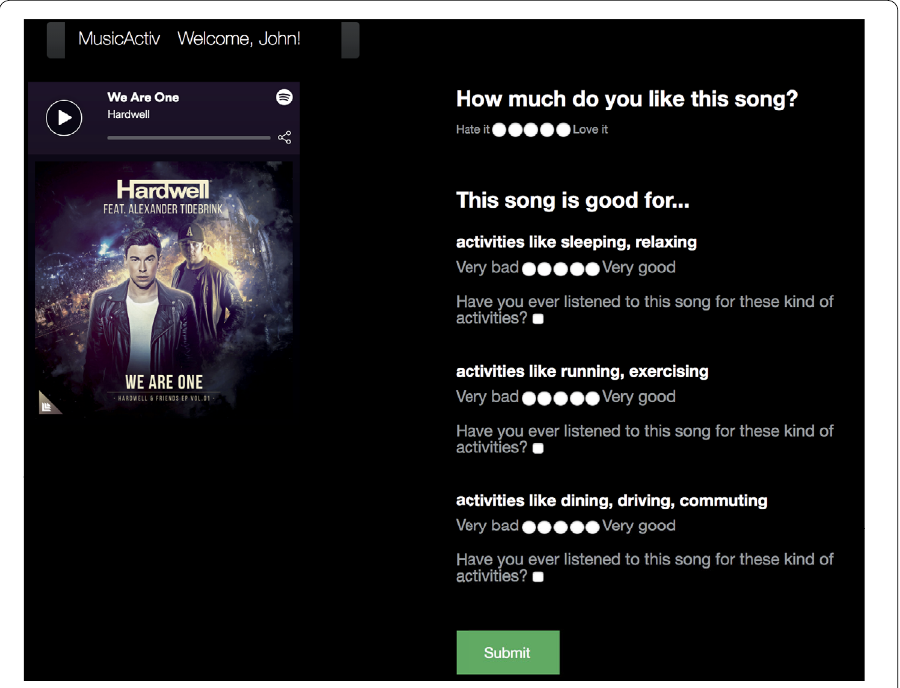
Figure 7 An interface for participants to evaluate the recommended songs. A user can listen to a 30-second preview (left), rate how much they like the song (top right), rate how good the song is for three